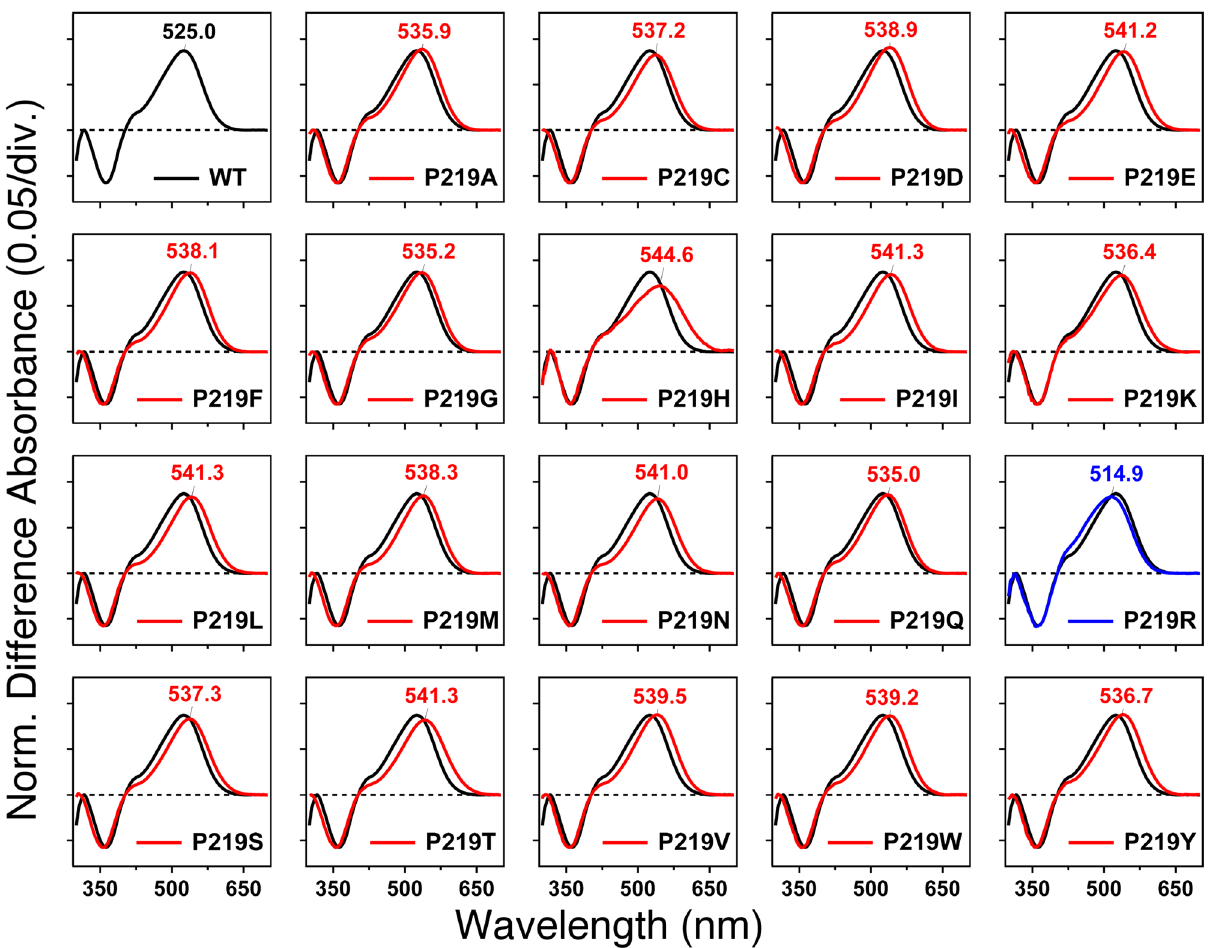
Fig. 2 Light-induced difference absorption spectra of the WT-KR2 (black curves) and 19 P219X mutants (colored curves) of KR2 in the presence of 500 mM hydroxylamine. Positive and negative signals show the spectra before and after illumination corresponding to those of the rhodopsin and retinal oxime, respectively. Red and blue curves represent red- and blue-shifted mutants, respectively. Mutant and WT-KR2 spectra were normalized by use of a negative peak at 361